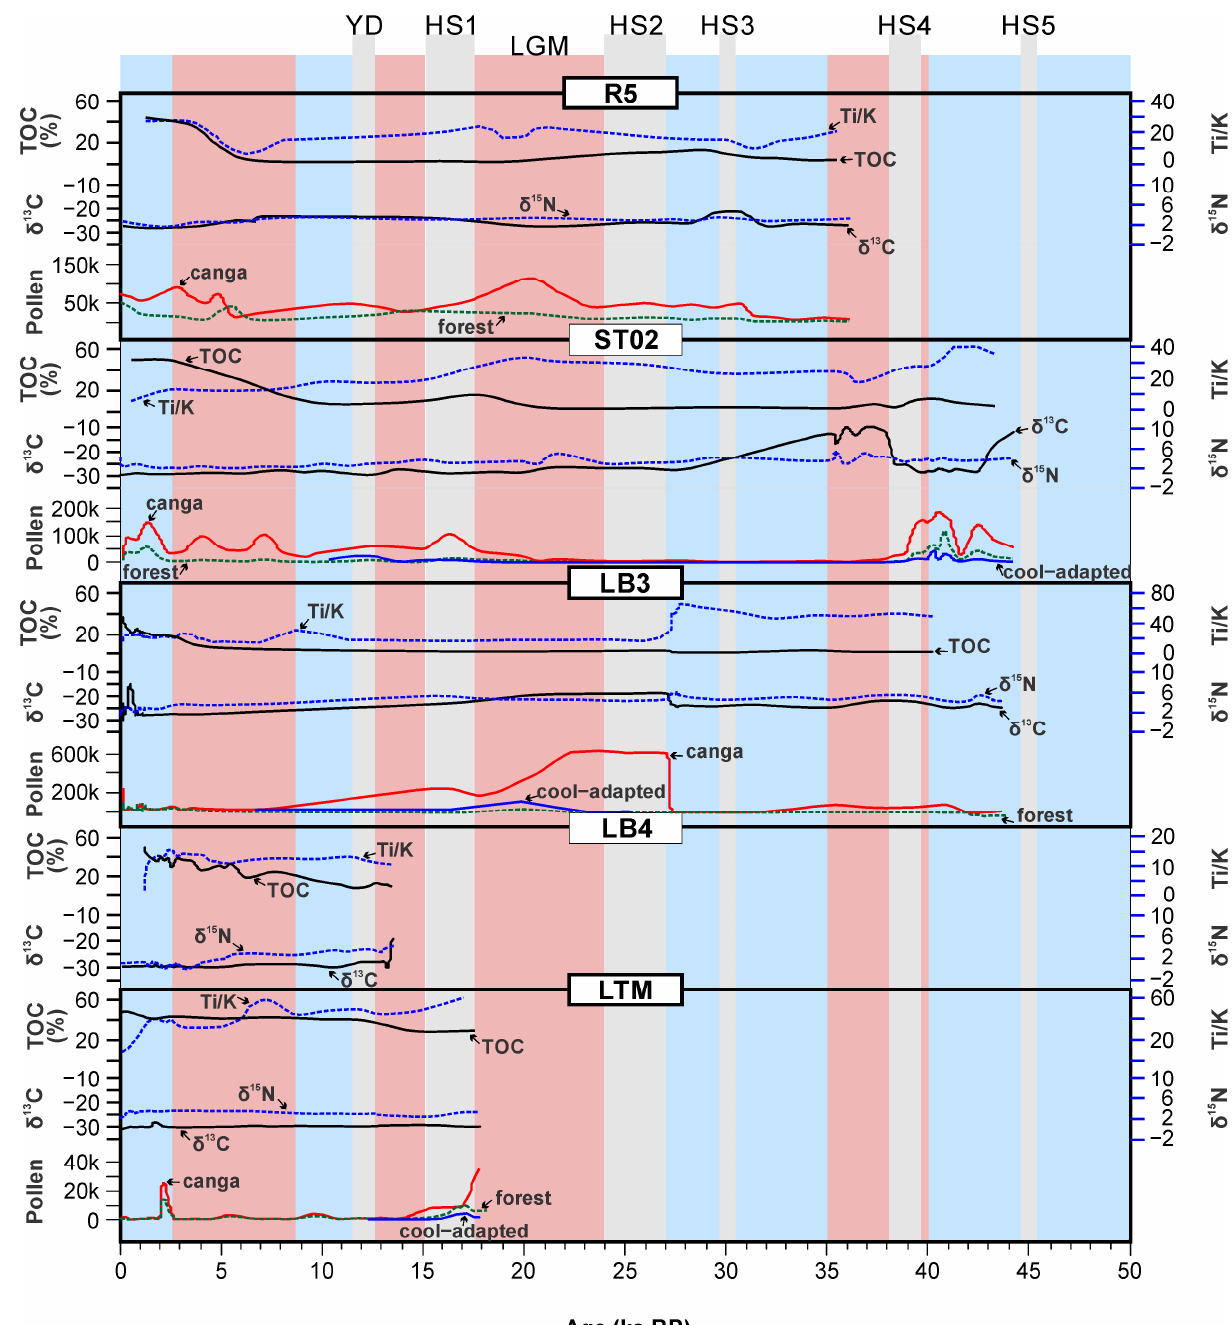
Figure 9. Generalized profile of the geochemical (Al/K and TOC with black line, Ti/K with blue-dashed line), isotopic (δ 13 C with black line, δ 15 N with blue dashed line), and pollen (canga vegetation with red line, forest with green dashed line and cool-adapted taxa with blue line) data of active (Três Irmãs, Violão and Serra Leste) and filled (R1, R2, R4, R5, ST02, LB3, LB4 and LTM) lakes. Light blue and red vertical bars represent wet and dry lacustrine phases in the ULs of Carajás [4,13,16,17,26,27]. Divided into 2 parts. YD (Younger Dryas), HS (Heinrich event) and LGM (Last Glacial Maximum).